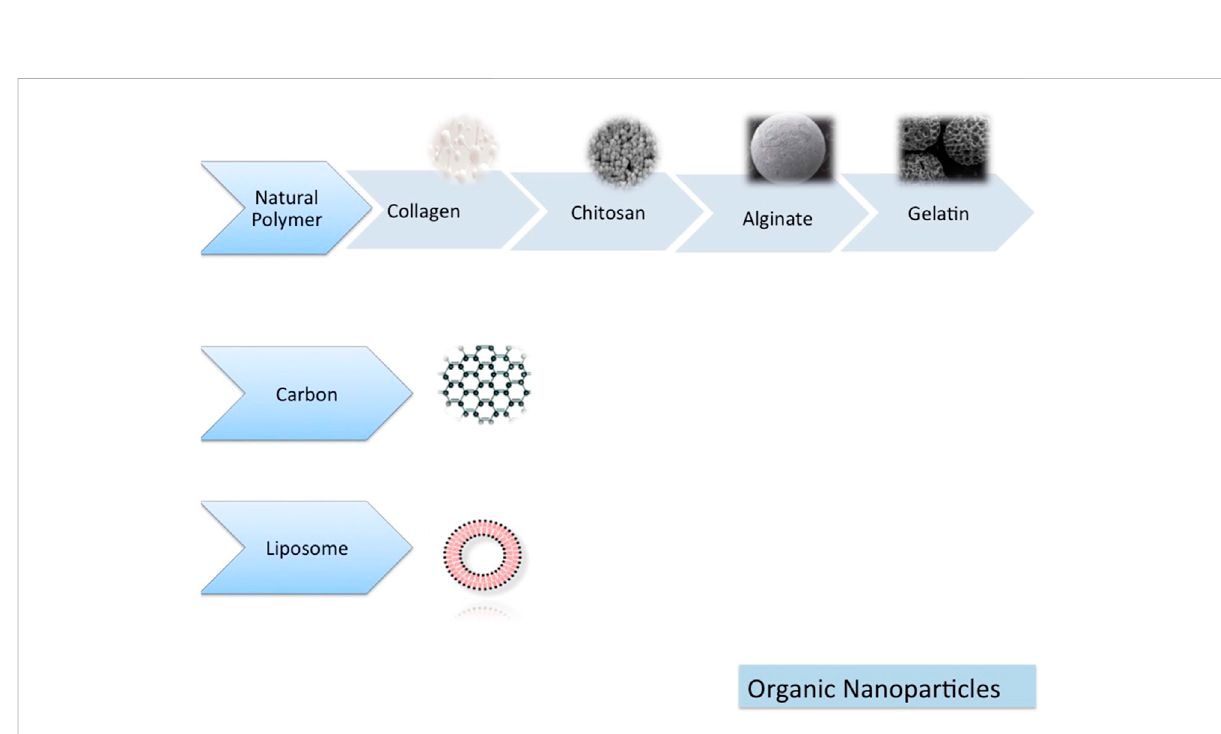
FIGURE 6 Organic nanomaterials (Funda et al.,